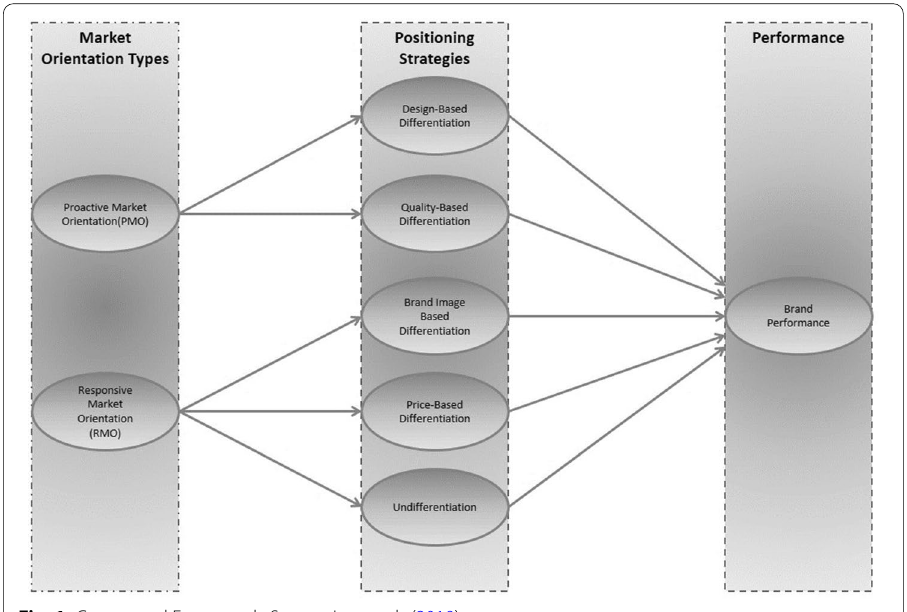
Fig. 1 Conceptual Framework. Source: Iyer et al.,